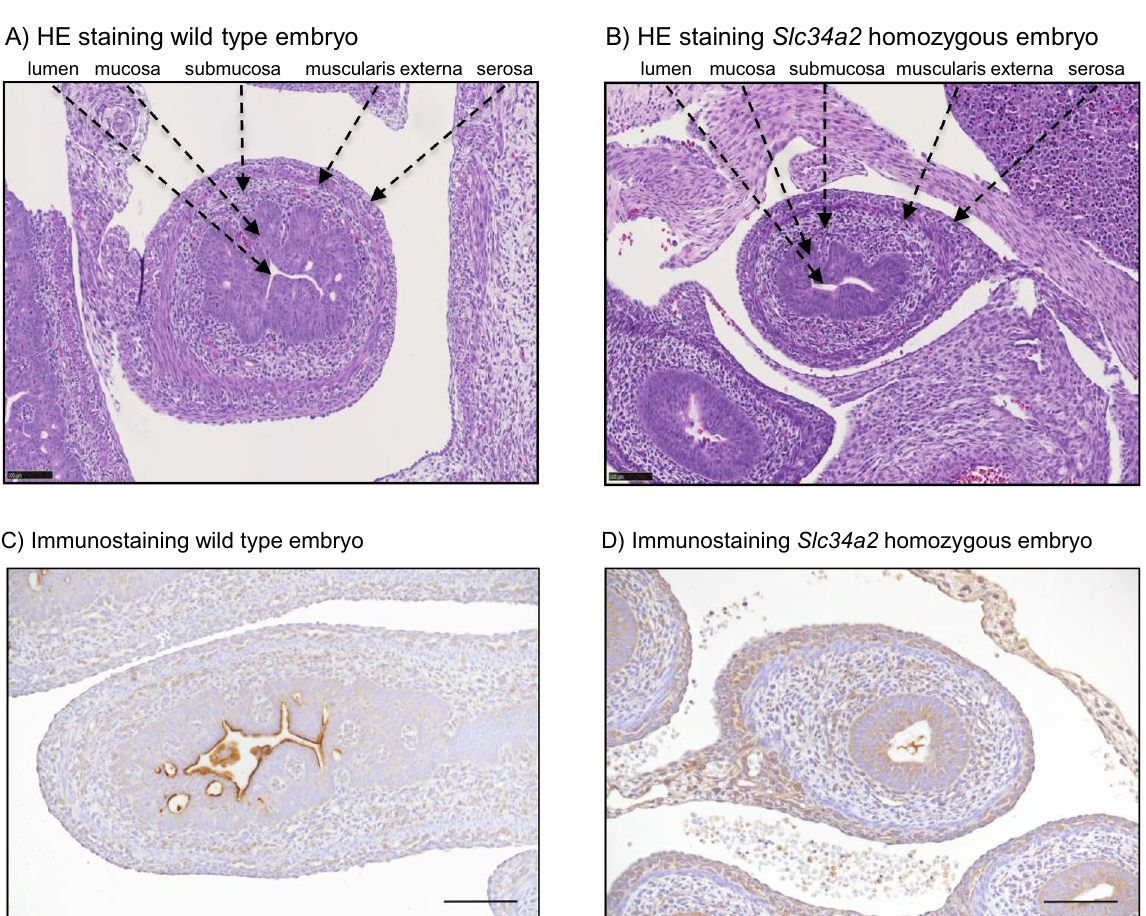
Figure 6. Intestines from ( A , C ) wild type and ( B , D ) Slc34a2 homozygous E18 embryos stained with ( A , B ) H&E or with ( C , D ) a NaPi-IIb antibody. Scale bars: 100 µm in ( A , B ); 50 µm in ( C , D